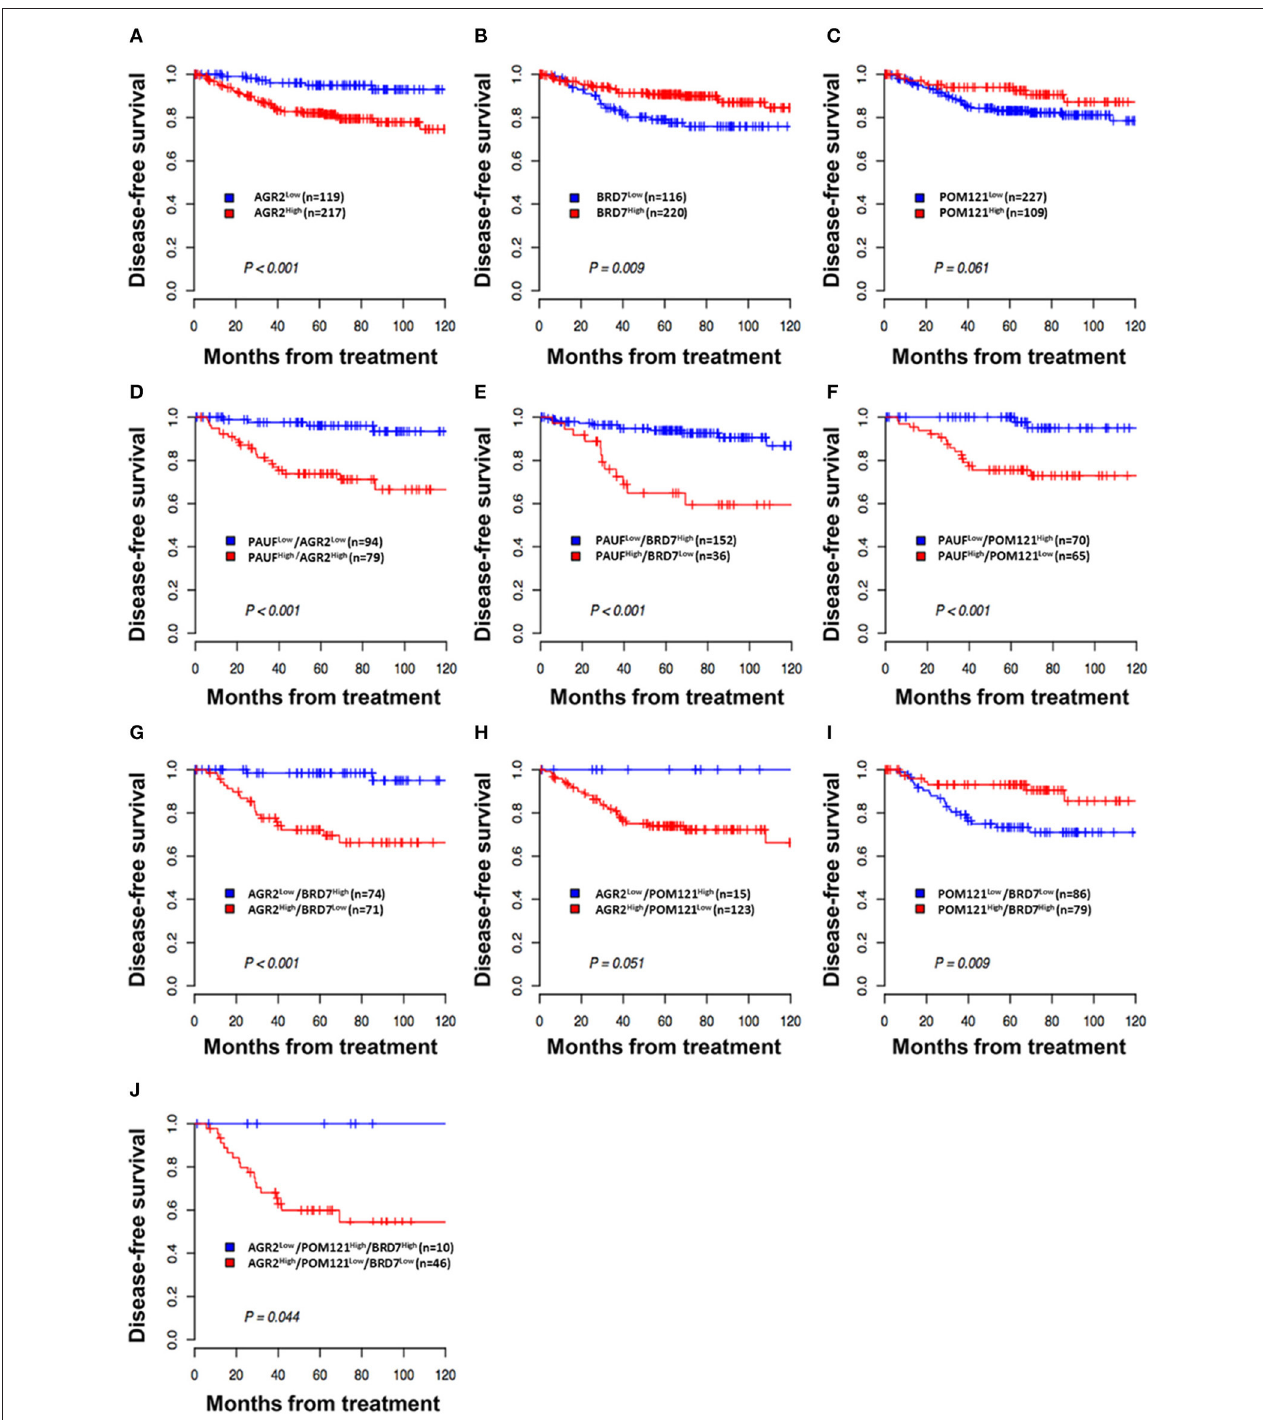
FIGURE 4 | Kaplan–Meier plot of disease-free survival according to expression of PAUF and PAUF-associated proteins. (A,B) Patients with high AGR2 expression (AGR2 High ) and low BRD7 expression (BRD7 Low ) showed worse disease-free survival ( log -rank test, p < 0.001 and p = 0.009, respectively) than patients with low AGR2 expression (AGR2 Low ) and high BRD7 expression (BRD7 High ). (C) Patients with low POM121 expression (POM121 Low ) showed a trend of worse disease-free survival. (D–F) Patients with combined PAUF High /AGR2 High , PAUF High /BRD7 Low , or PAUF High /POM121 Low expression showed shorter disease-free survival ( log -rank test, p < 0.001, p < 0.001, and p < 0.001, respectively) than patients with the opposite combined expression profile. (G–J) Patients with combined AGR2 High /BRD7 Low , BRD7 Low /POM121 Low , or AGR2 High /BRD7 Low /POM121 Low expression showed shorter disease-free survival ( log -rank test, p < 0.001, p = 0.009, and p = 0.044, respectively) than patients with combined AGR2 Low /BRD7 High , BRD7 High /POM121 High , or AGR2 Low /BRD7 High /POM121 High expression.